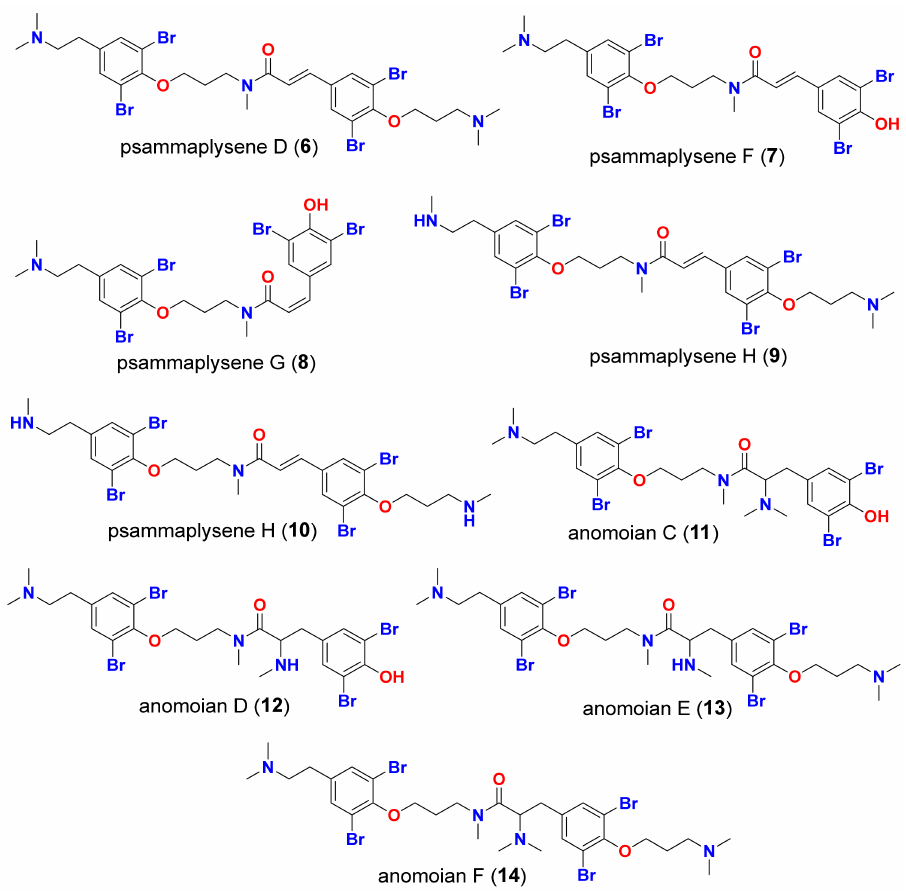
Figure 3. Isolated bromotyrosine derivatives ( 6–14 ) from the marine sponge, Suberea ianthelliformis